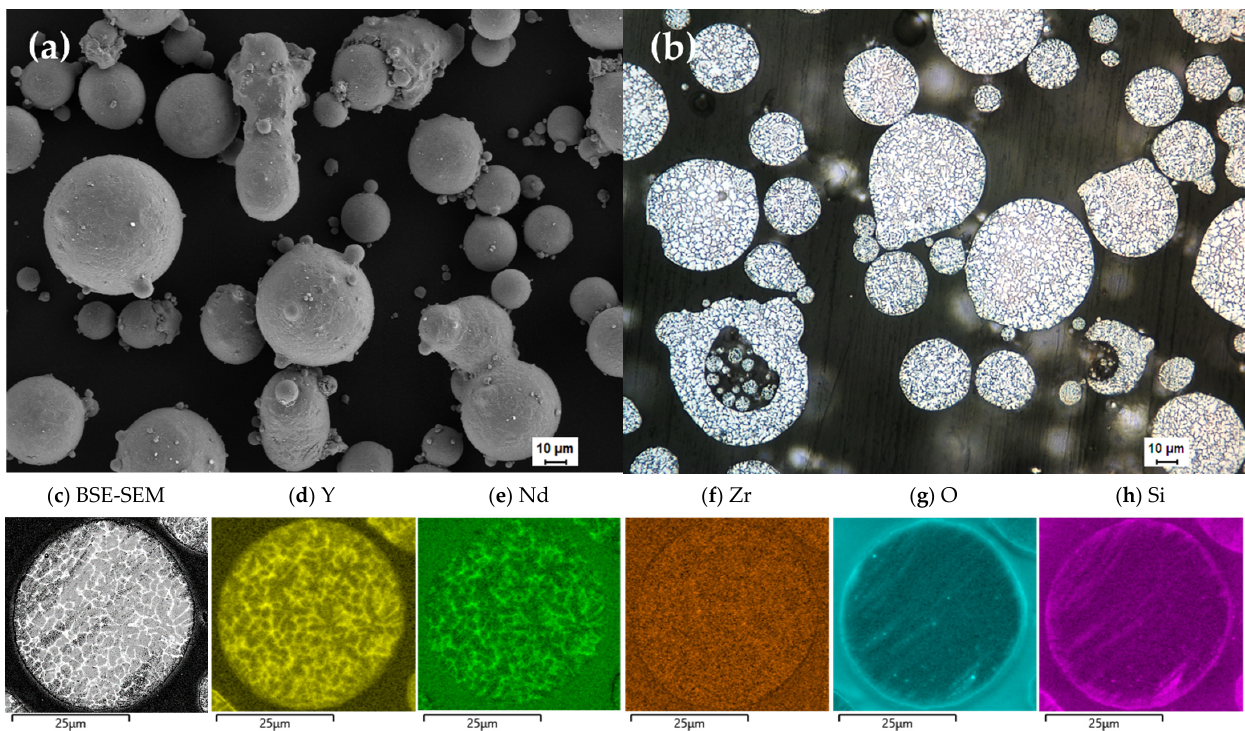
Figure 1. ( a ) SE-SEM image of the gas-atomized WE43 powder; ( b ) LOM image of the cross section of the powder; ( c ) BSE-SEM images of the cross section of the powder; and ( d – h ) EDS maps of Y, Nd, Zr, O and Si, respectively.